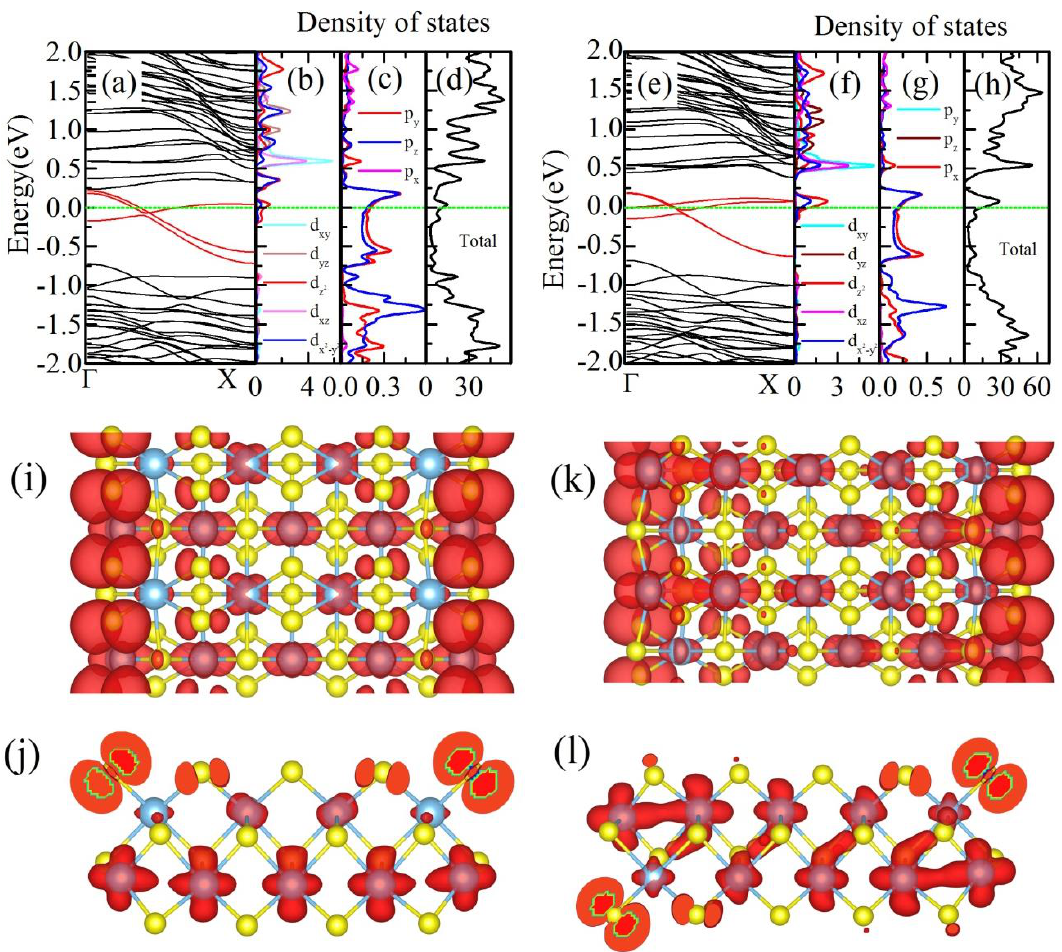
Figure 2. ( a ) and ( e ) are the band structures of 9- a -TiS 3 NR and 10-a-TiS 3 , respectively, within the GGA calculation. Three bands, which cross the Fermi level and are denoted by red color, are the edge states. ( b ) and ( f ) are the density of states of d-orbital of edge Ti atoms in 9- a -TiS 3 NR and 10-a-TiS 3 NR respectively. ( c ) and ( g ) are the density of states of p-states of edge S atoms in 9- a -TiS 3 and 10- a -TiS 3 NRs; ( d ) and ( h ) are the total density of states of 9- a -TiS 3 and 10- a -TiS 3 NRs respectively. ( i ) and ( j ) are the charge density of three red bands of 9- a -TiS 3 NR. ( k ) and ( l ) are the charge density of three red bands of 10- a -TiS 3 NR. ( i ) and ( k ) are the top view while ( j ) and ( l ) are the side view along the period direction.